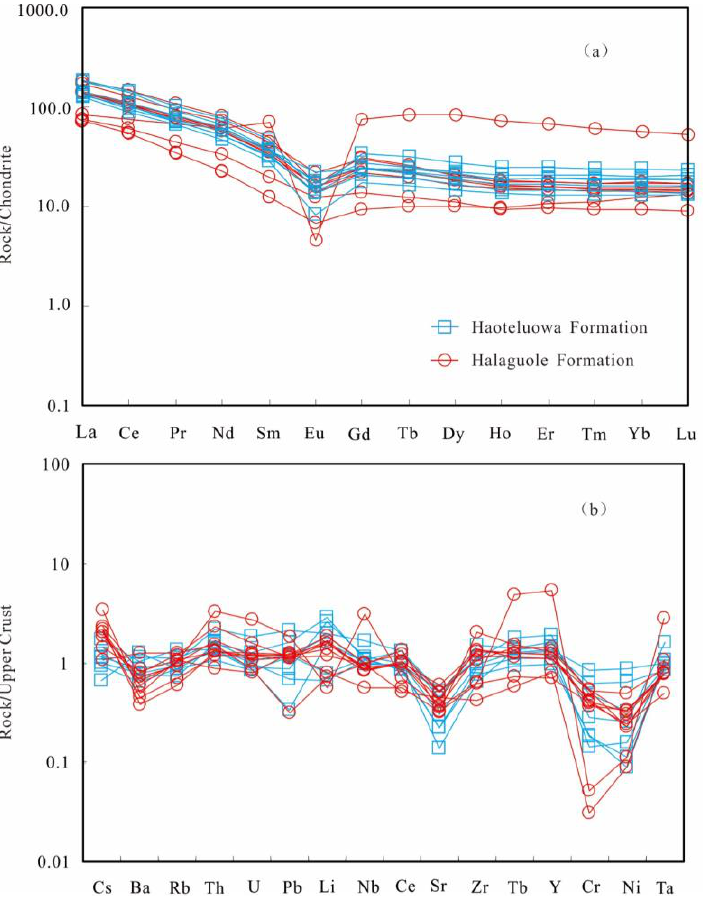
Figure 4. ( a ) Chondrite-normalized REE patterns (Chondrite data from Sun and McDonough [44]), and ( b ) upper crust-normalized trace element spider pattern of the sandstones from Alake Lake, EKO (upper crust data from Taylor and McLennan [45]).